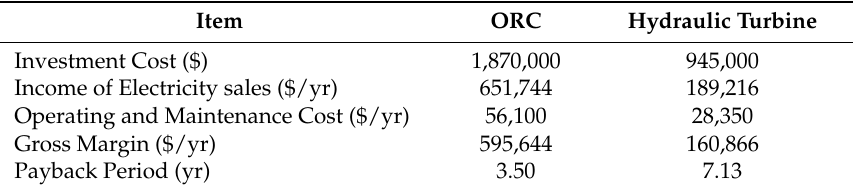
Table 9. Results of economic